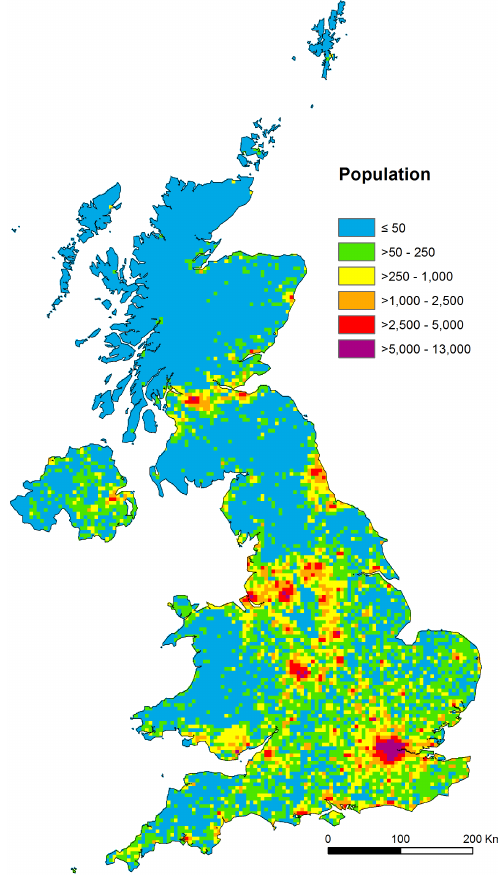
Figure 3. 2010 monthly-averaged EMEP4UK simulated PM 2 . 5 components and total PM 2 . 5 observations by TEOM-FDMS at the Edinburgh St. Leonards, London North Kensington and Harwell UK national network (AURN) monitoring sites. Both the modelled and observed data are averaged from hourly values. The linear re- gression between the monthly averaged observation and model is also shown at the top of each panel, along with the correlation coef- ficient, r , bias and mean square